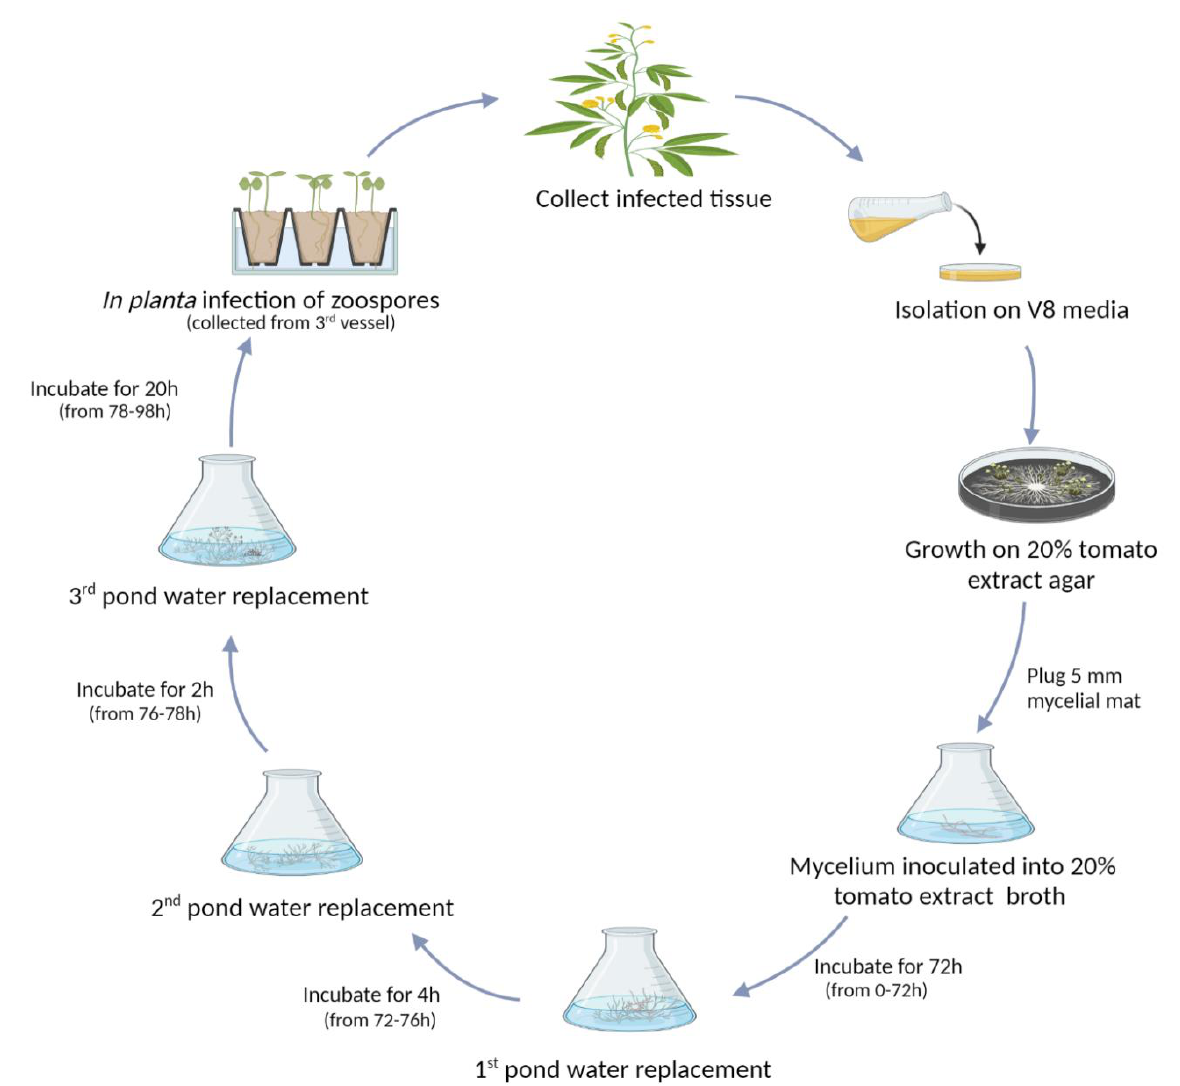
Figure 1. Schematic diagram of the protocol for production of sporangia and zoospores and in planta infection of P. cajani in pigeonpea seedlings. Sterilized pond water was used in each water replacement step. The time period was calculated from ‘0 h’ (i.e., first inoculation of P. cajani in 20% tomato extract broth).